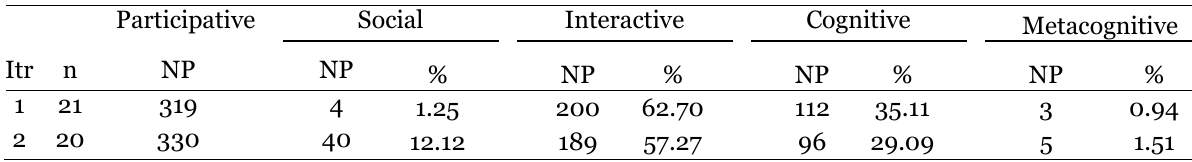
Table 2 Dimension Range for Discussion Posts in Iteration One and Iteration Two* Participative Social Interactive Cognitive Metacognitive